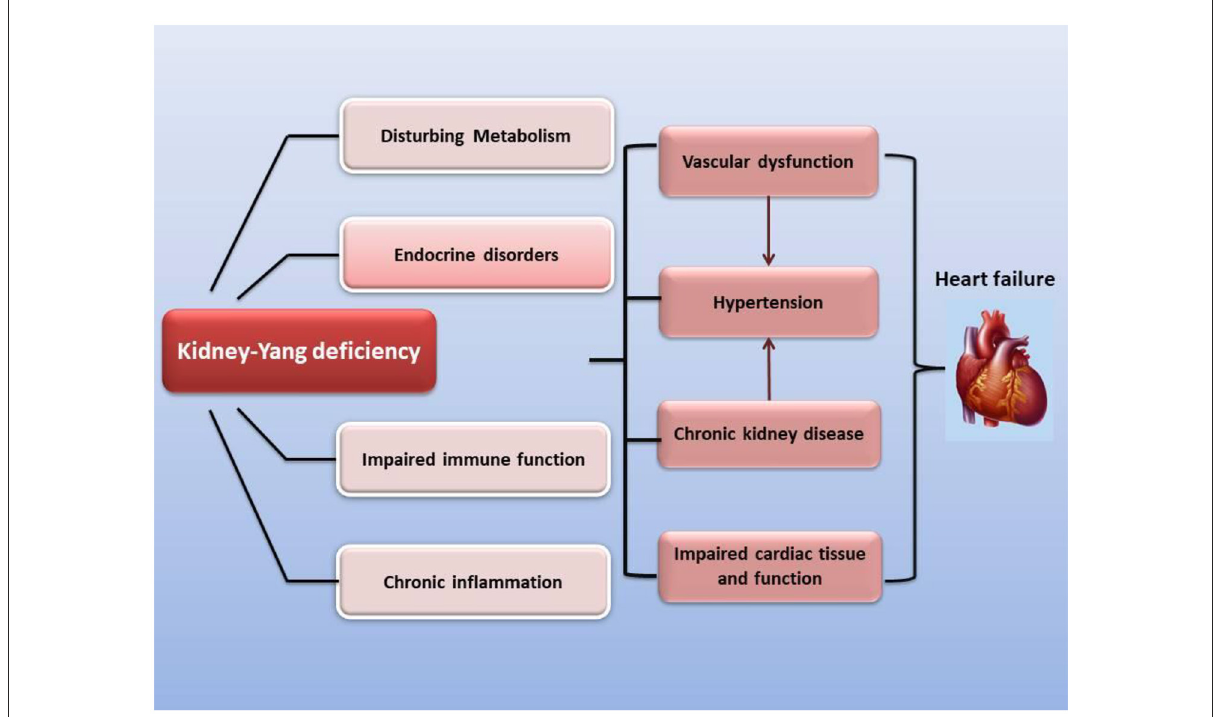
FIGURE1 The modern medical understanding that kidney-Yang deficiency promotes the development of chronic heart failure. Kidney-Yang deficiency leads to metabolic disturbances, endocrine disorders, immune function imbalance, and low-grade chronic inflammation, which further contributes to vascular dysfunction, hypertension, chronic kidney disease, and cardiac tissue and functional imbalance, and eventually guides to chronic heart